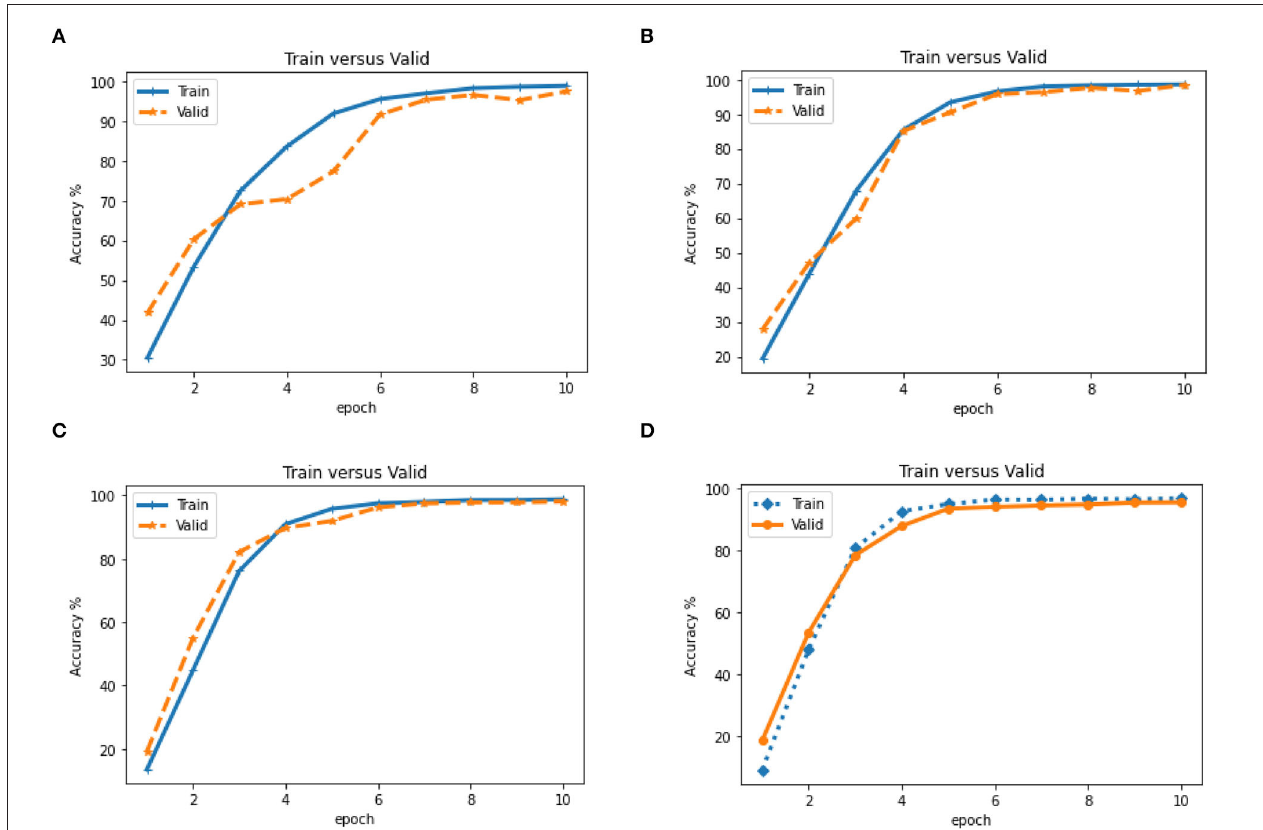
FIGURE 6 | Evaluation of accuracy (Train vs. Valid) in different epoch based on CNN model on four states of the dataset (A) . Dataset on Year (B) . on ± 6-month (C) . on ± 3 month and (D) . on ± 1 month. (A) Train vs. Valid for dataset years. (B) Train vs. Valid for the dataset with ± 6 months. (C) Train vs. Valid for the dataset with ± 3 months. (D) Train vs. Valid for the dataset with ± 1